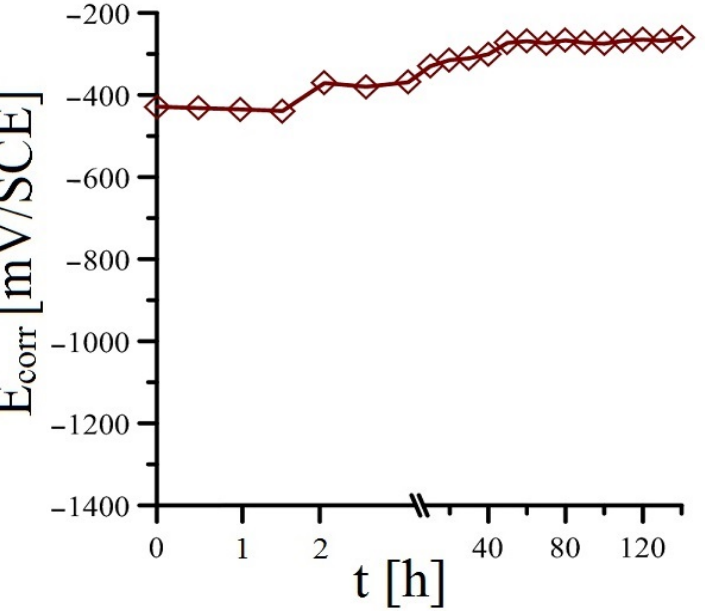
Figure 8. Evolution of open-circuit potential (E corr ) in samples of HDG steel in concrete with addition of MnO 4 − (Mn (3) )—(mean values).